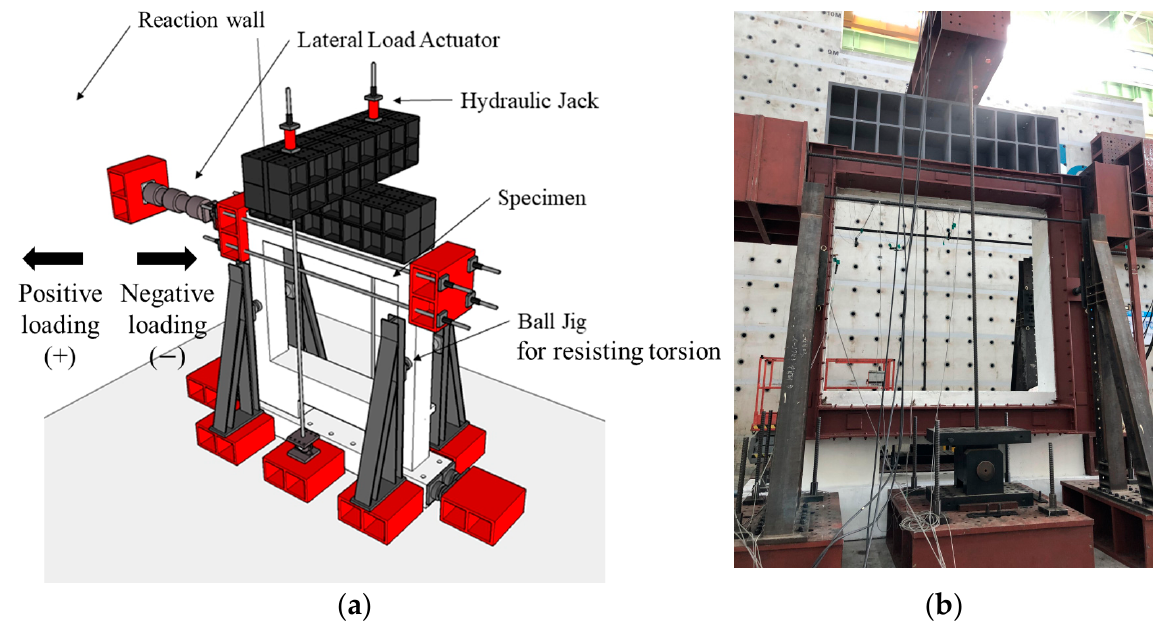
Figure 7. Cyclic loading tests: ( a ) concept of experiment; ( b ) photograph of test setup.